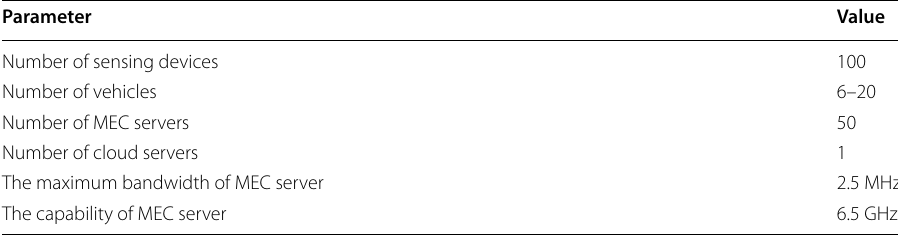
Table 1 Experimental parameters